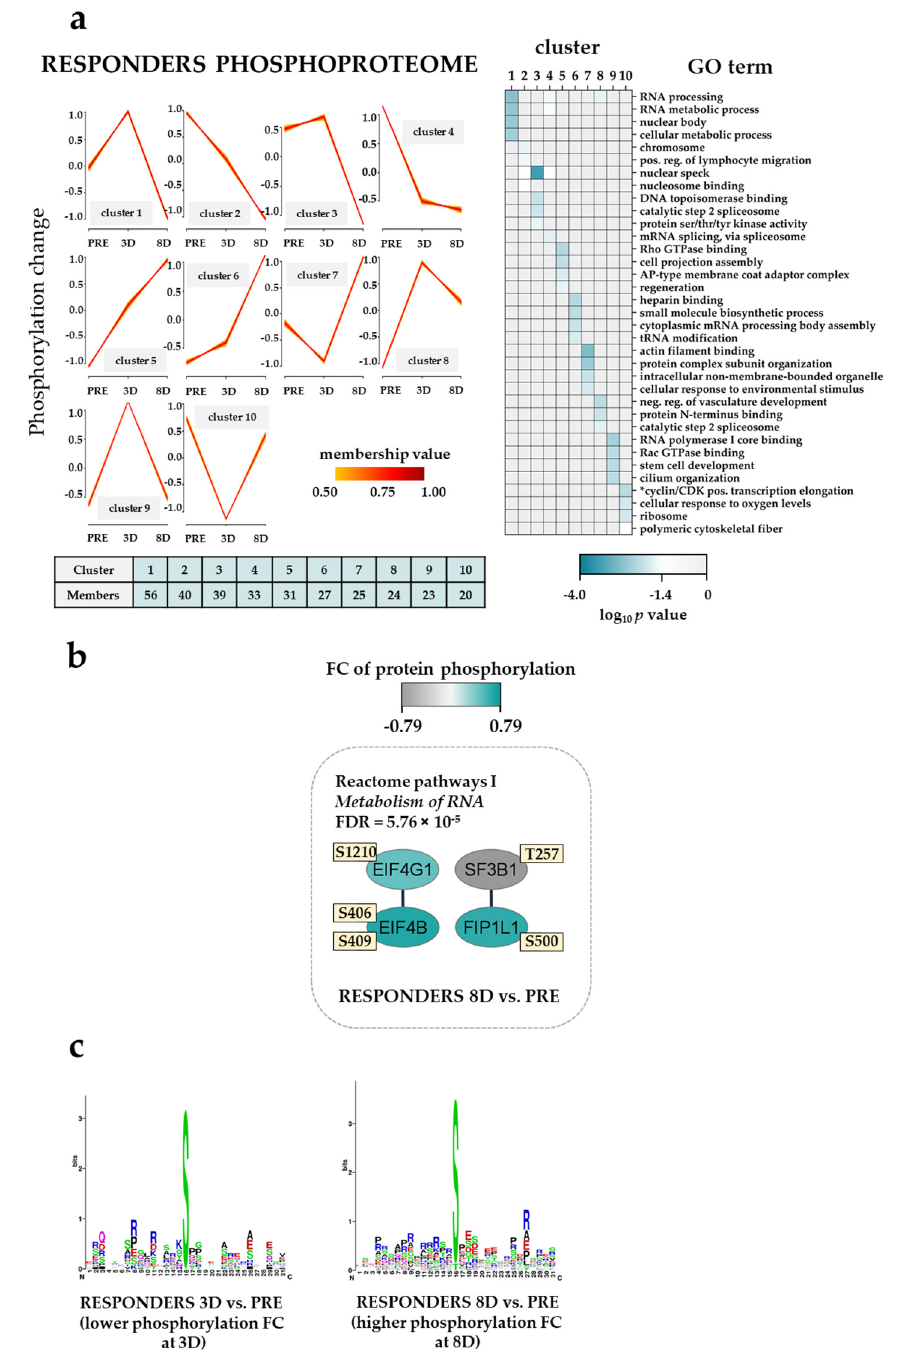
Figure 6. Protein phosphorylation profiles of responders before treatment (PRE) and after two days of ATRA treatment (3D) followed by ATRA–VP–TP treatment for five additional days (8D): ( a ) standard fuzzy c-means clustering of the protein phosphorylation profiles of responders at the three treatment time points and GO term enrichment analysis of each of the phosphoproteome clusters shown as a heatmap. * Full name of the abbreviated GO term is cyclin/CDK positive transcription elongation factor complex. Reg., pos. and neg. are abbreviations for regulation, positive and negative, respectively; ( b ) Reactome term enrichment of the regulated phosphoproteins identified in the temporal pair-wise comparison 8D vs. PRE which was performed as indicated in the legend of Figure 4; and ( c ) sequence motif analysis of the ± fifteen amino acids flanking the differentially regulated phosphorylation sites for the temporal pair-wise comparison 3D vs. PRE and 8D vs. PRE.